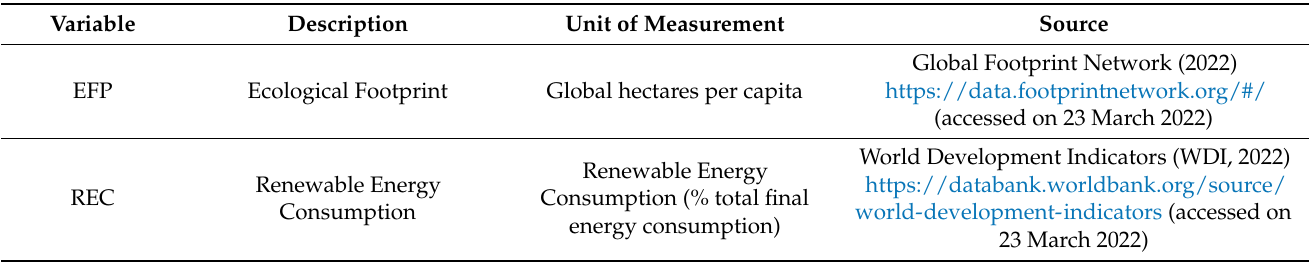
Table 1. Description of